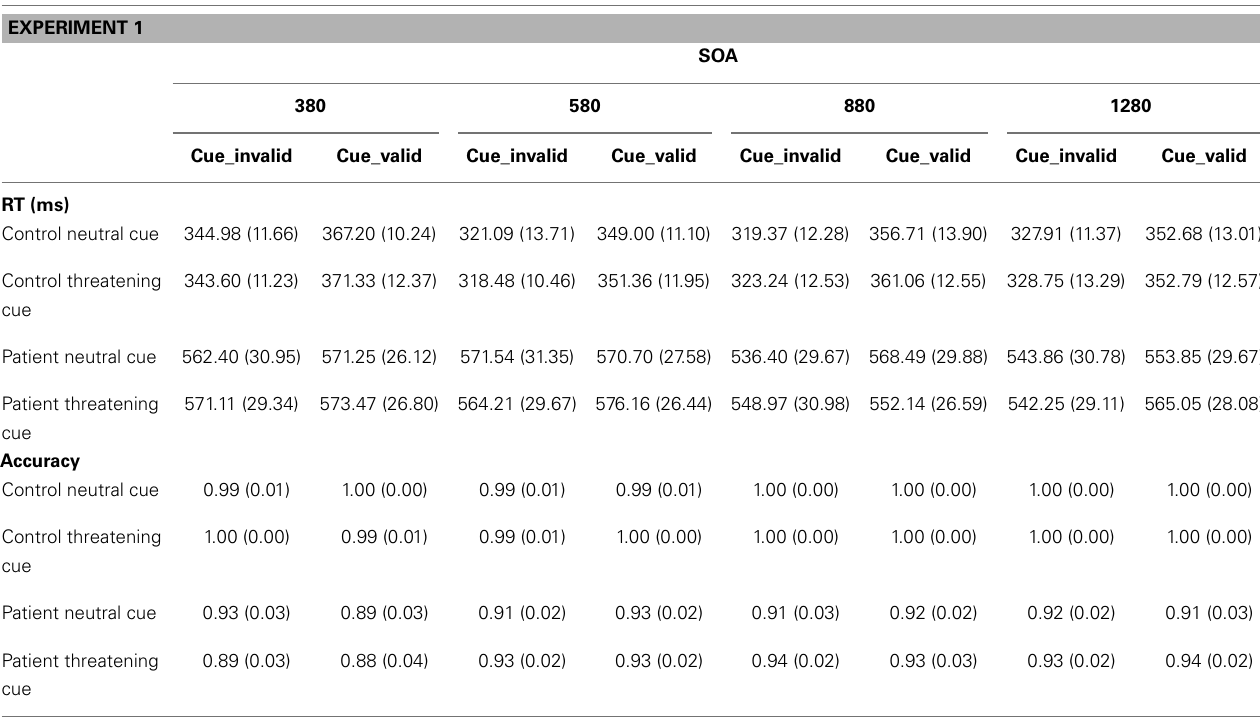
Table 2 | Mean reaction times (ms) and accuracy as a function of CueValence (threatening vs. neutral), Cueing (valid vs. invalid), and SOA in Experiment 1 .